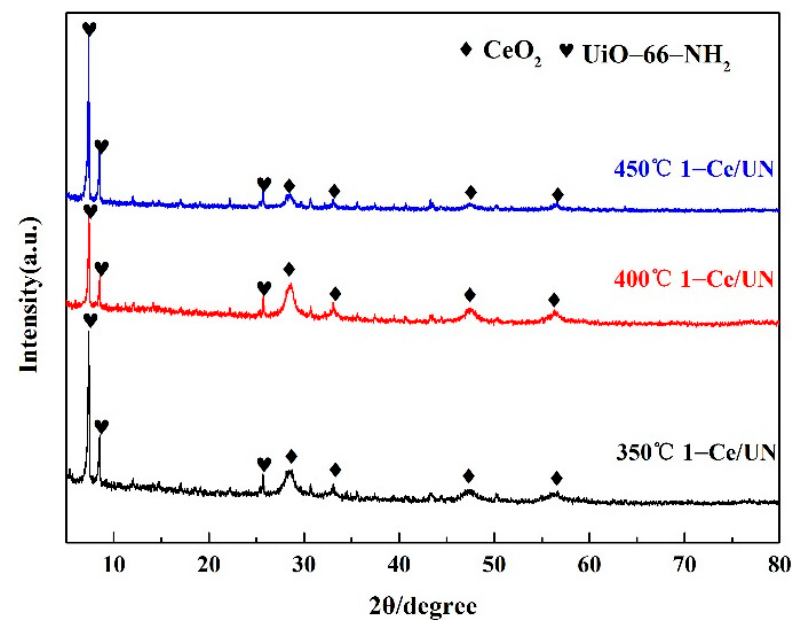
Figure 4. XRD patterns of 1-Ce/UN at different temperatures.